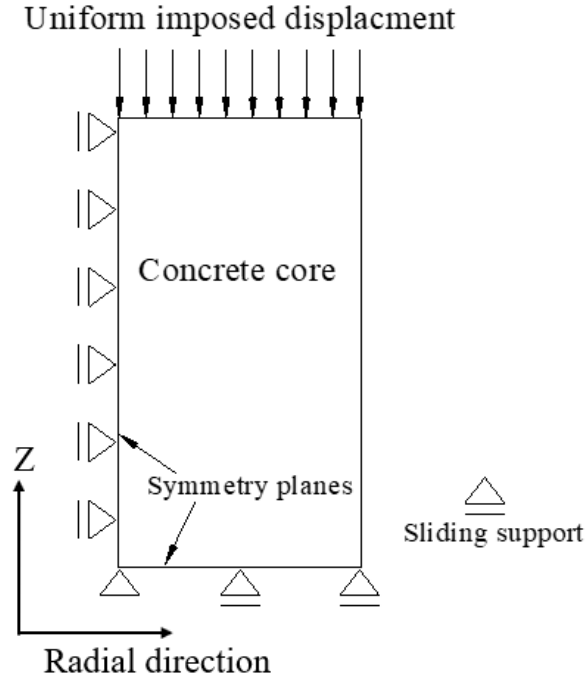
Figure 14. Boundary conditions and loading of the simulated column specimens.